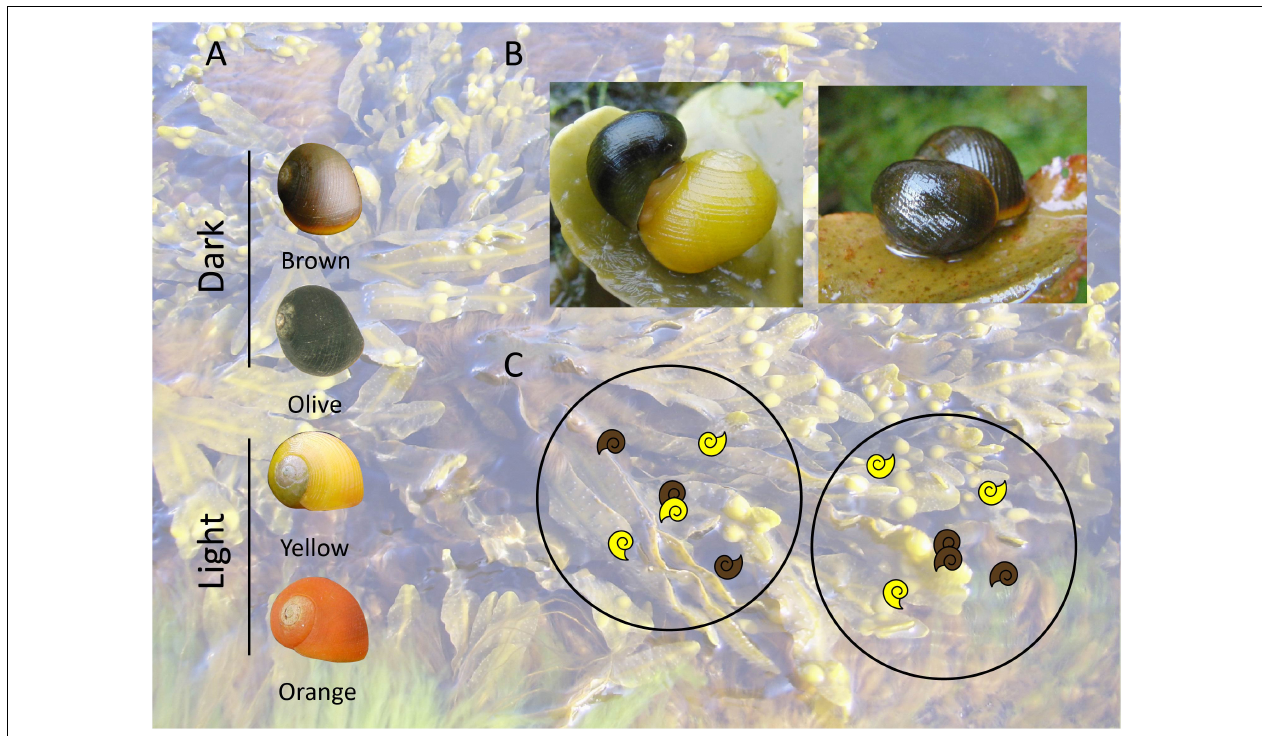
FIGURE 2 | Experimental design for the analysis of sexual selection in L. fabalis . (A) Representative shells of the different colors (brown, olive, yellow, orange) and color categories (dark, light) present in Abelleira and in the White Sea. (B) Example of heterotypic (dark/light) and homotypic (dark/dark) mating pairs on Fucus algae in the field. During the mating the male crawls on top of the female and positions on her right side. (C) Mating pairs sampling design carried out. Once a mating pair is found (center) and collected, then 4 unmated individuals are collected within a 10 cm diameter microarea (black